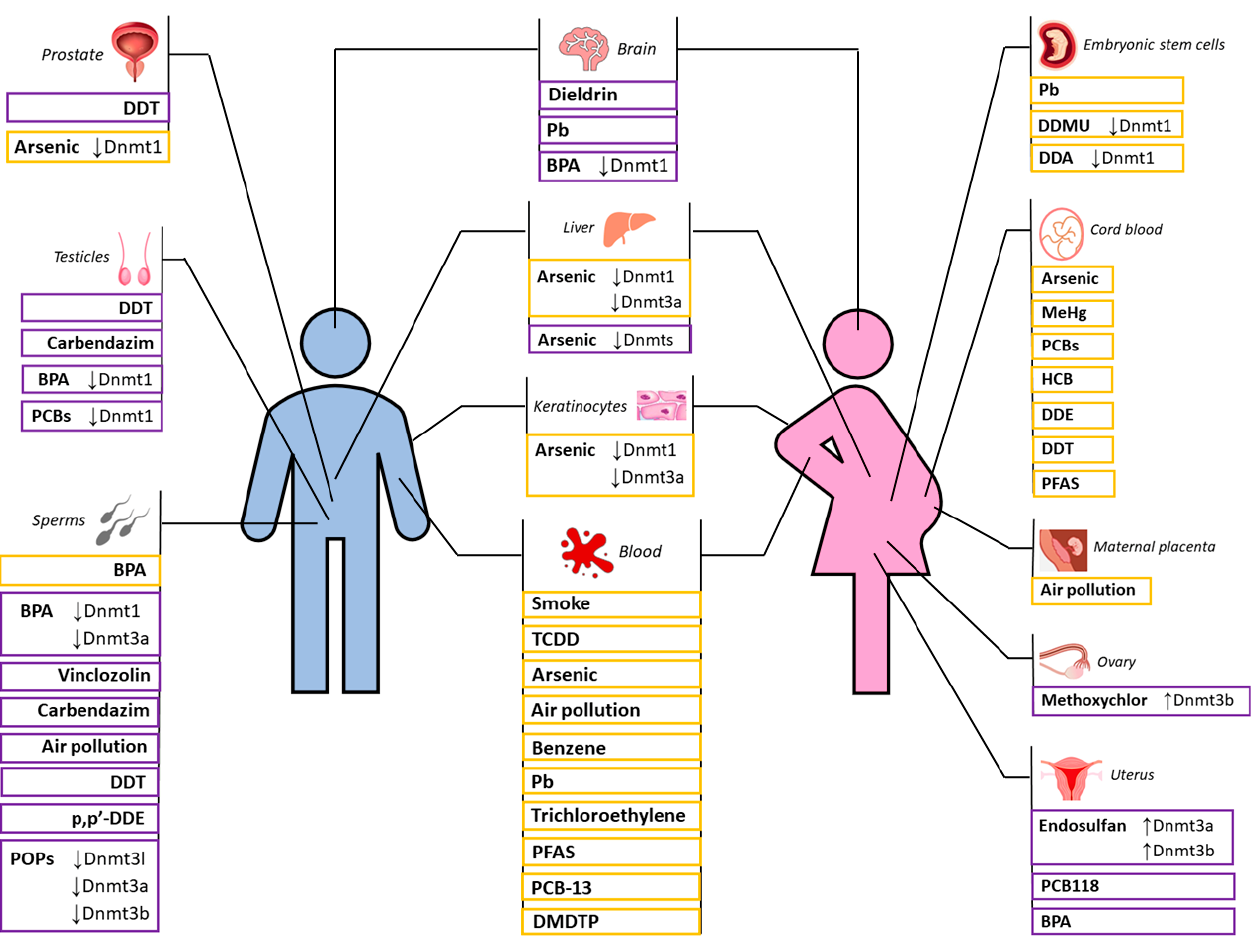
Figure 3. Schematic illustration summarizing the DNA methylation changes in different tissues after exposure to the main toxic agents examined in this review, with particular focus on the effect on Dnmts. The yellow boxes indicate the human studies, while the purple boxes indicate the mouse model studies.